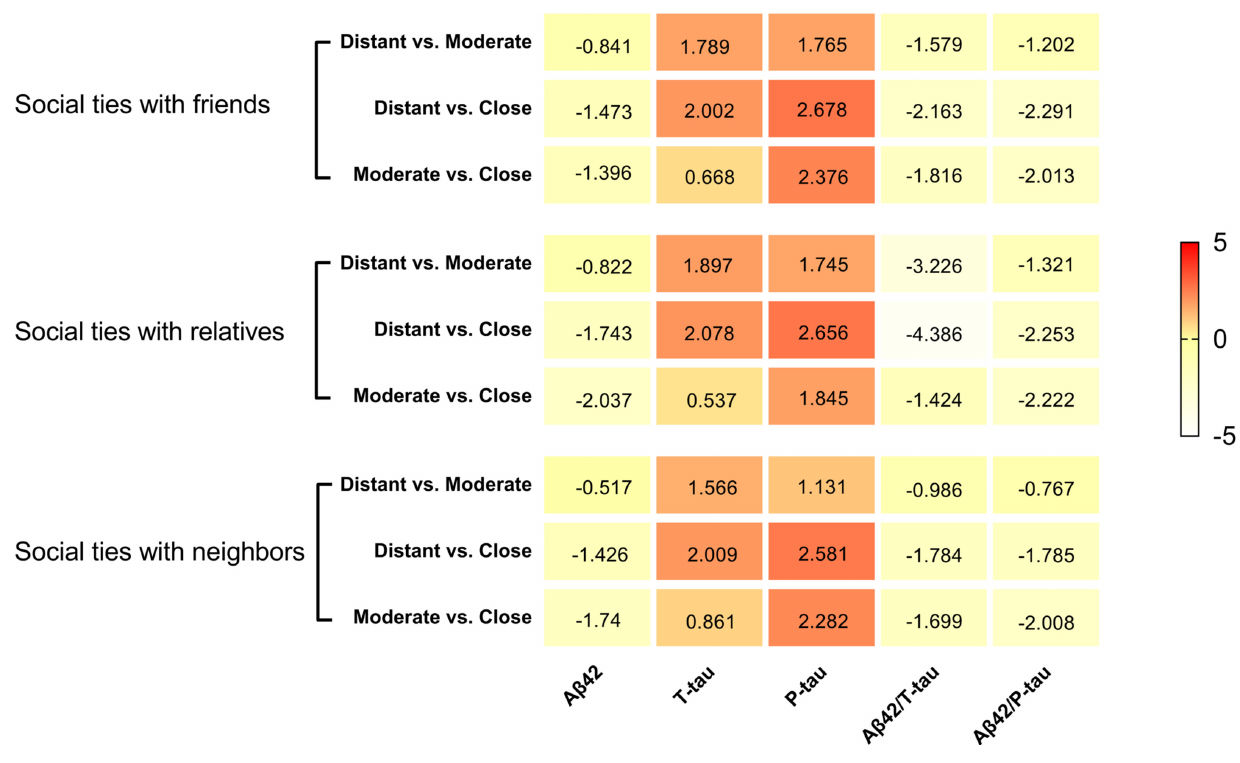
FIGURE 3 | Heat maps for social networks and CSF biomarkers of POD. The social networks showed several suggestive or significant associations with CSF indicators of multiple pathologies of POD in the whole participants. The color-coding and the positive or negative number in each cell represent a comparison of mean values between the two groups inferred from the Independent-Samples T